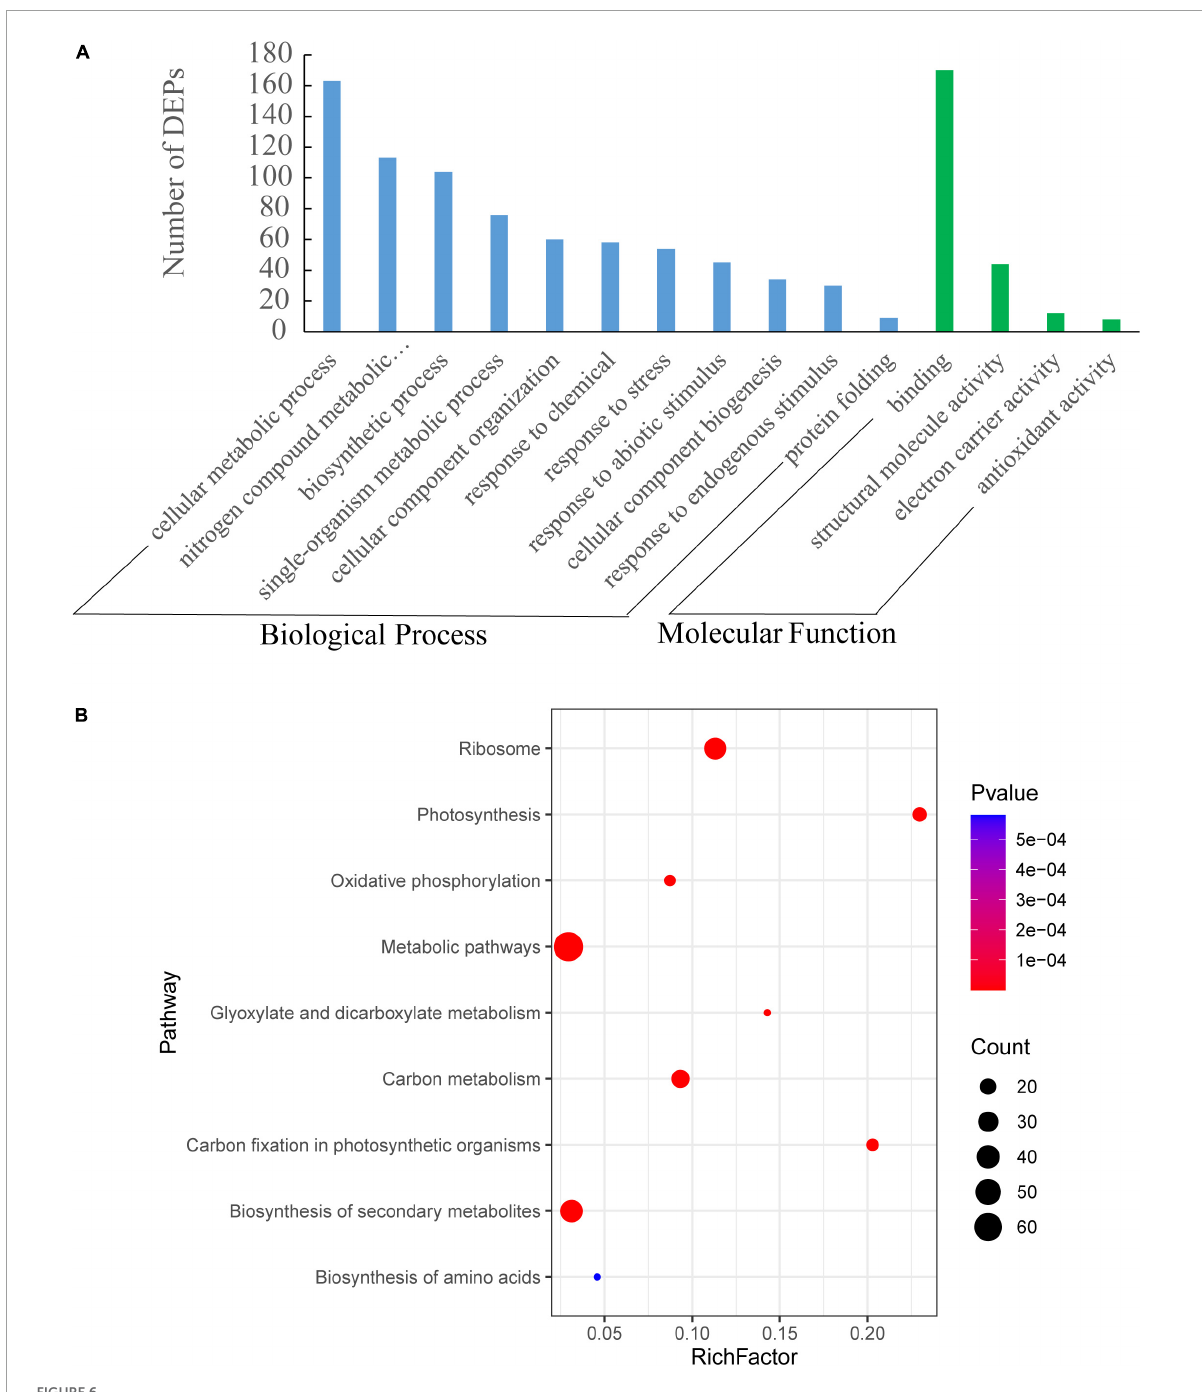
FIGURE6 Gene ontology (GO) (A) and Kyoto Encyclopedia of Genes and Genomes (KEGG) (B) enrichment analyses of differentially expressed proteins (DEPs) under different row spacing treatments. (A) GO analysis includes biological processes and molecular function. (B) Y -axis indicates KEGG pathway name, and X -axis represents enrichment factor. The dot size and colors represent the numbers of DEPs in each pathway and the P -values of enrichment, respectively.